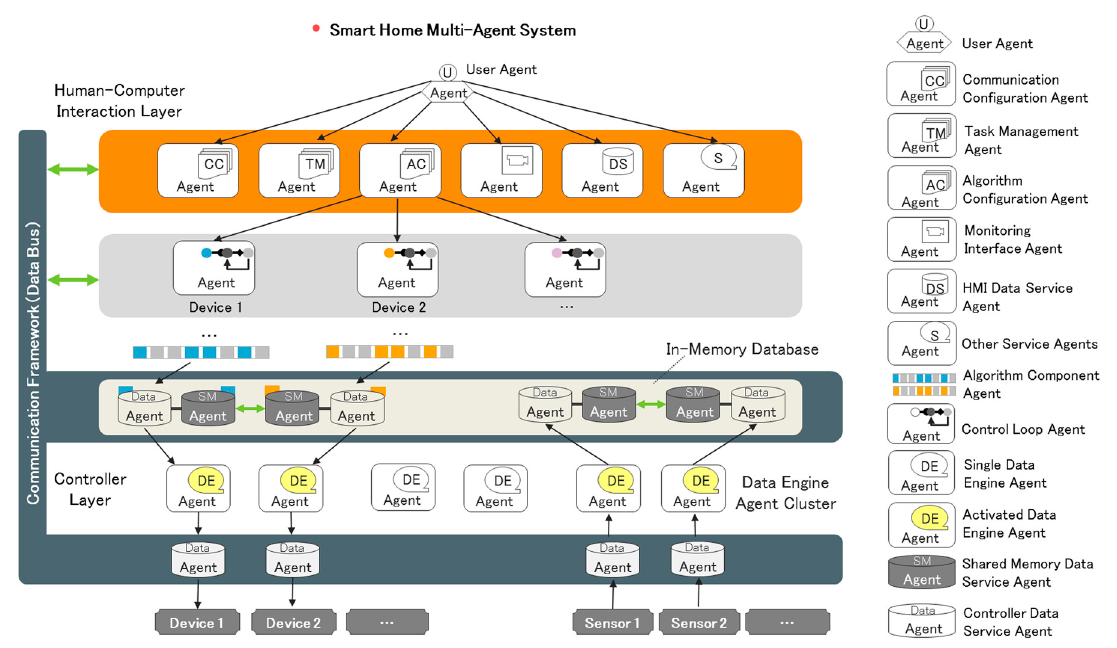
Figure 6. Multi-agent architecture of IAPhome and the information flow of collaborative control.